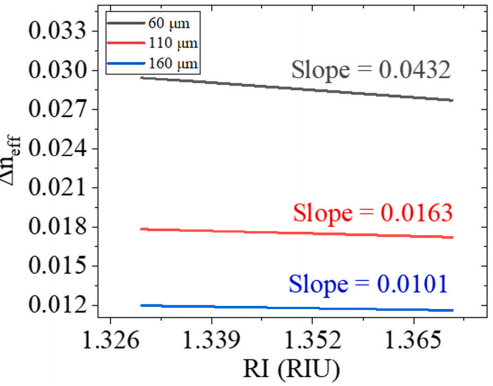
Figure 2. The relationship between the refractive index and ∆ n ef f , A (between the fundamental mode and high-order mode) for three fiber diameters [40]. Reprinted with permission from Ref. [40]. Copyright 2022 Elsvier Science and Technology